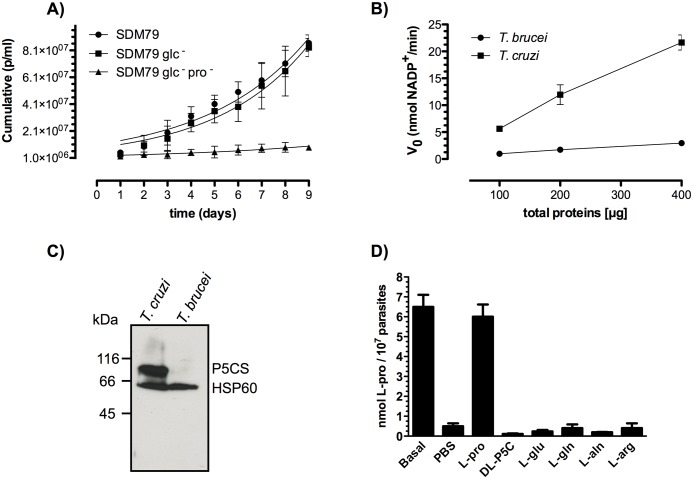
Procyclic forms of T. b. brucei are auxotrophic for proline.A) Growth rates of PCF maintained in complete SDM79, SDM79 glucose-depleted (SDM79 glc-) or SDM79 media that contained neither glucose nor proline (SDM79 glc- pro-). Cell densities were determined daily, and cells were split every 72h. Plots represent cumulative cell numbers determined over 9 days. B) Enzymatic assay for pyrroline-5-carboxylate reductase (P5CR) activity. Kinetic rates were determined spectrophotometrically by monitoring the NADPH oxidation (Abs340nm) resulting from P5C reduction into proline. Activities were measured in total lysates from replicative forms of T. brucei and T. cruzi (used as positive control). The plot represents initial velocities (V0) in the function of protein variations used in the P5CR assay. C) Detection of pyrroline-5-carboxylate synthase (P5CS) in cell-free lysates. Protein samples from replicative T. b. brucei and T. cruzi cells (used as positive control) were electrophoresed on SDS-PAGE, blotted onto PVDF membranes and probed with polyclonal antibodies raised against TcP5CS and Heat shock protein (HSP)-60 kDa (TcHSP60), used as reference for protein loads. Expected protein sizes were 81 and 60 kDa for TcP5CS and TcHSP60, respectively. D) Intracellular proline content in PCFs incubated under different precursors. Proline concentration was determined from cells cultivated in SDM79 media (Basal) and after one hour in PBS proline levels were depleted (PBS). Then, proline restoration was assessed over 40 min in the presence of: L-proline (L-pro) used as control, DL-pyrroline-5-carboxylate (DL-P5C/γGS), L-glutamate (L-glu), L-glutamine (L-gln), L-alanine (L-ala), L-arginine (L-arg). Reactants concentrations are detailed in the supplementary data section.